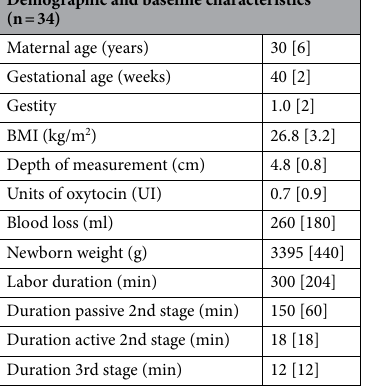
Table 1. Demographic, obstetrical and neonatal characteristics. Data are presented as median values [interquartile range].